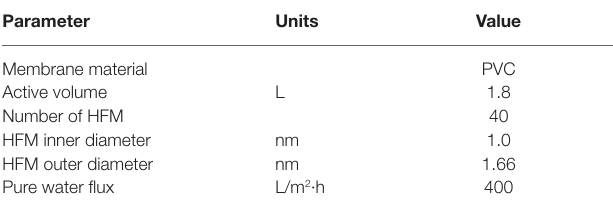
TABLE 1 | Physical characteristics of the MBfR system. Parameter Units Value Membrane